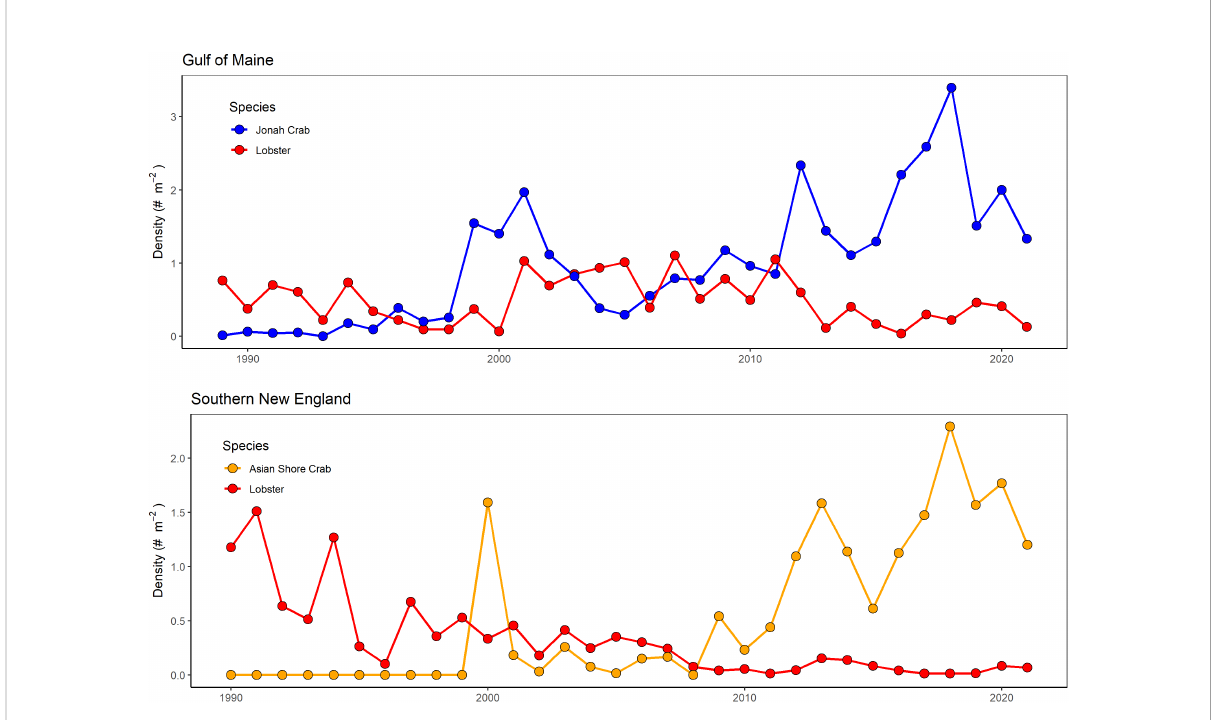
FIGURE 6 Depiction of emerging taxa in relation to young-of-year American lobster in US waters: Jonah crab in the Gulf of Maine (top) and Asian shore crab in southern New England (bottom). Gulf of Maine indices represent those from the Mid-coast Maine site and Southern New England indices are aggregated from Rhode Island and Buzzards